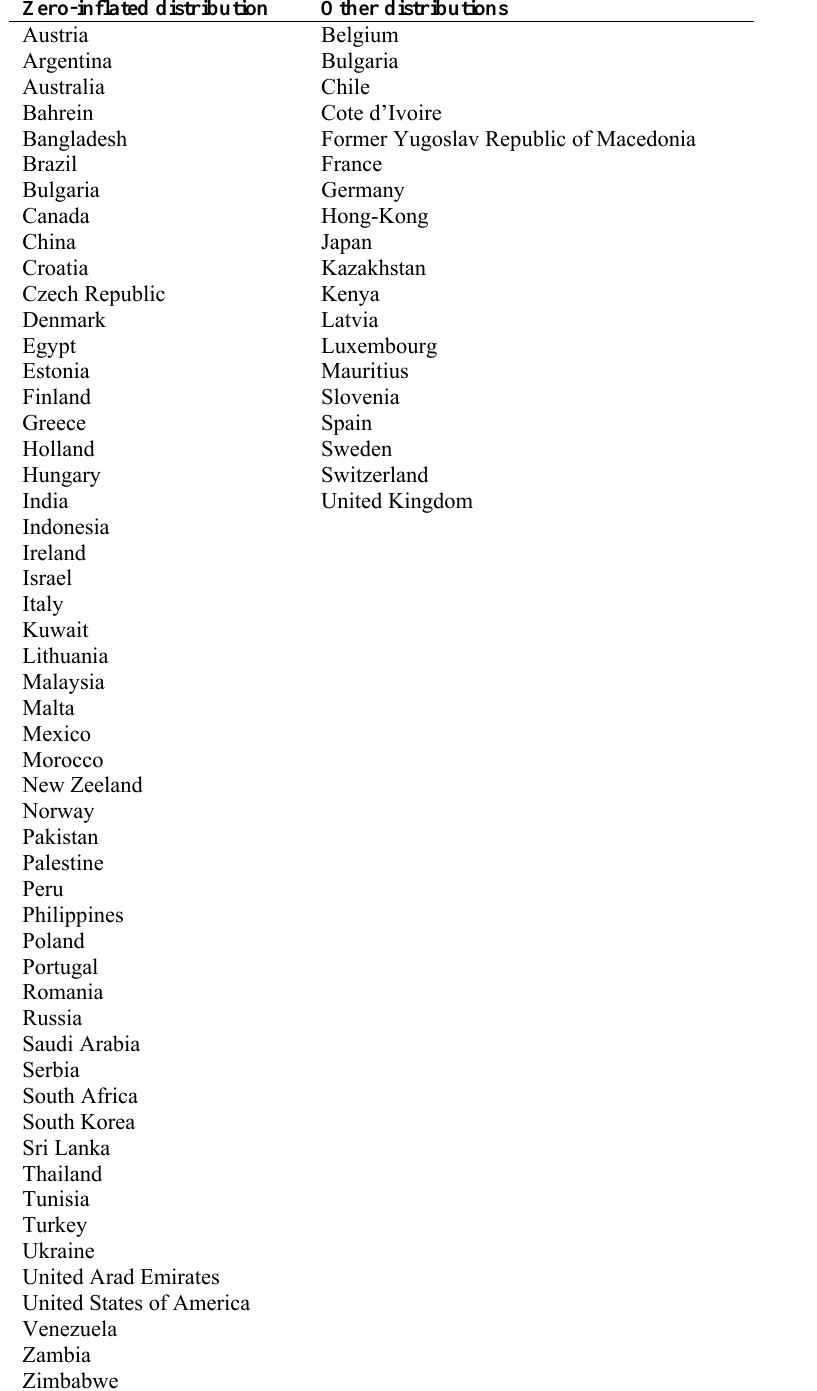
Table A.3.1 : Countries with zero-inflated distributions versus countries with other distributions of Dividend payout